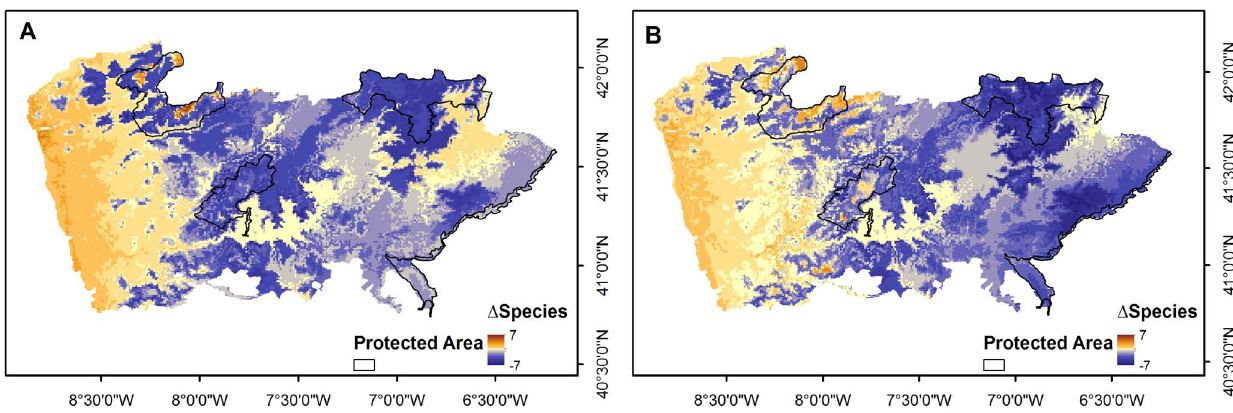
Figure 4. Predicted variation in climatic space between the present and the future. Predicted variation in climatic space for target species between the present and the future under climatic scenarios A2a (A) and B2a (B) for the year 2080. Negative n Species values indicate loss of climatic suitable space while positive indicate species gain of climatic suitable space. Most important protected areas are also represented.